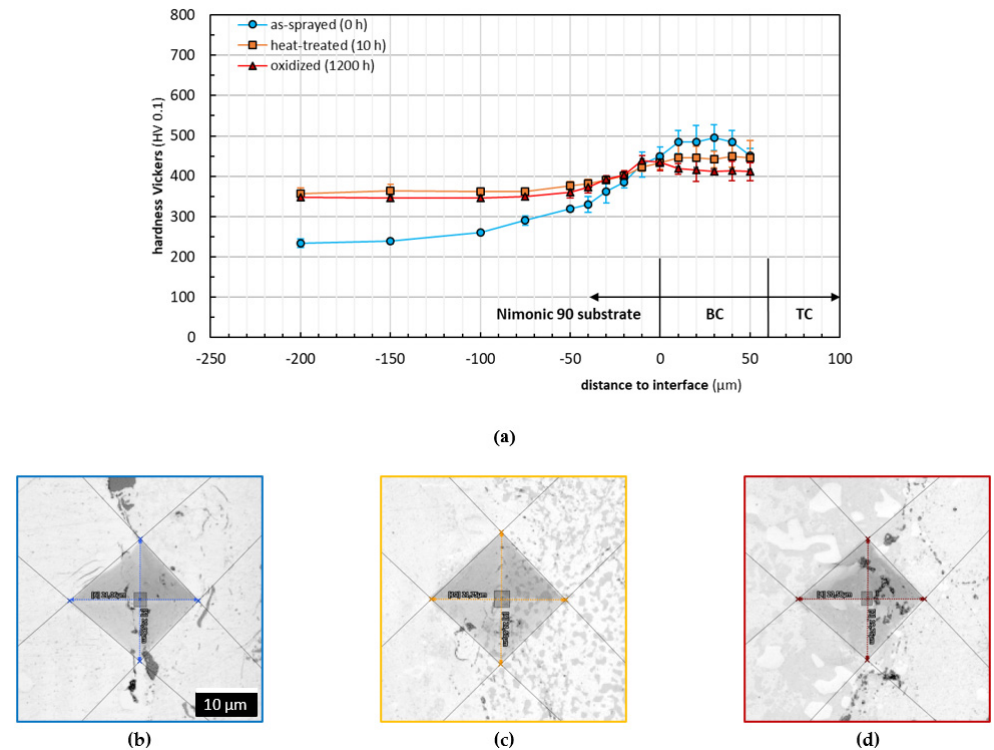
Figure 10. Evaluation of materials microhardness perpendicular to the interface substrate/BCs: ( a ) Vickers microhardness profiles and corresponding cross-section CLSM micrographs of exemplary indents at the interface substrate/BCs: ( b ) as- sprayed (blue framed), ( c ) heat-treated (orange framed), and ( d ) isothermally oxidized (red framed).